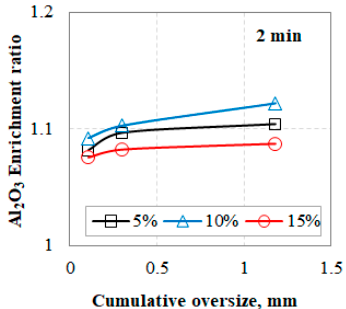
Figure 9. Al 2 O 3 enrichment ratio in the cumulative oversize after 2 min of grinding when different material filling volumes f c were used.